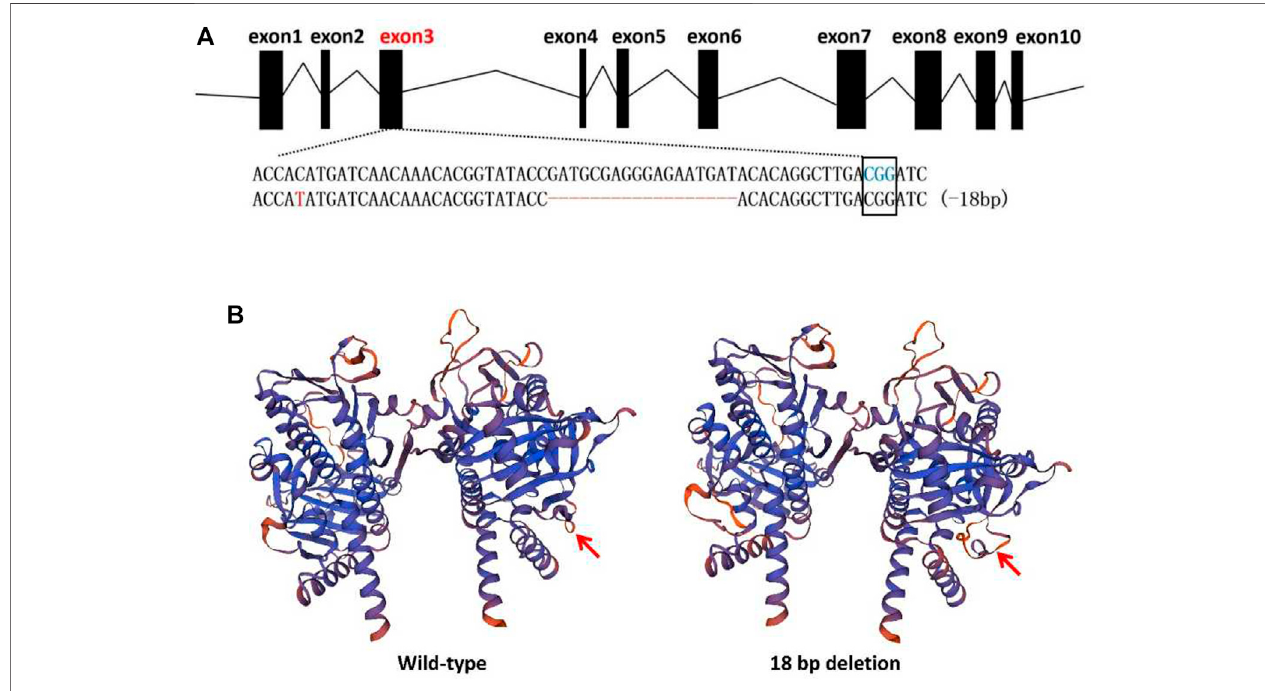
FIGURE 5 | Mutant alleles and homology modelling of the 18 bp deletion in F1 generation. (A) The wild-type sequence was shown at the top with the target sites and the PAM (blue letters) was marked with black box. In mutant sequence, deletions were shown as red dashes and point mutation was shown as red letter. (B) Predicted 3D structure of the wild-type Tuta absoluta cinnabar protein (left) compared to the structure of the 18 bp deletion mutant (right). The deletion is predicted to cause the loop changes (red arrow).